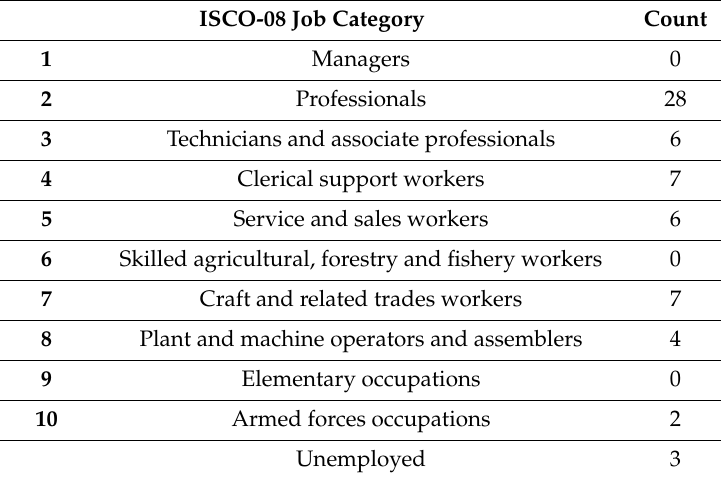
Table 2. Participants’ occupation distribution according to the International Standard Classification of Occupations (ISCO-08).